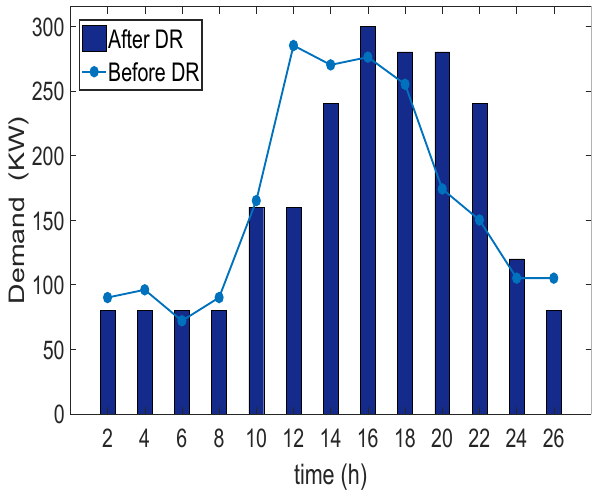
Figure 5. Load demand with and without involvement of demand response